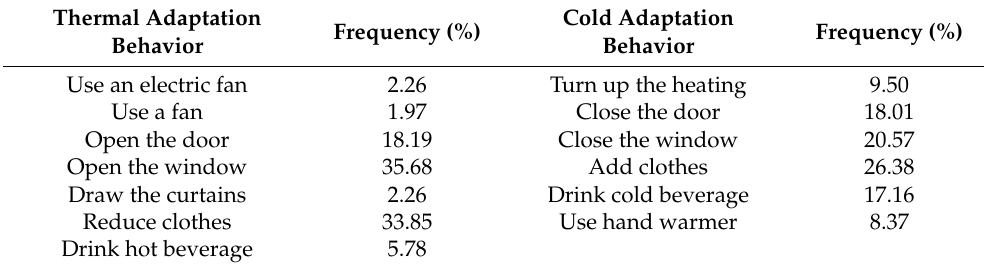
Table 12. Adaptive